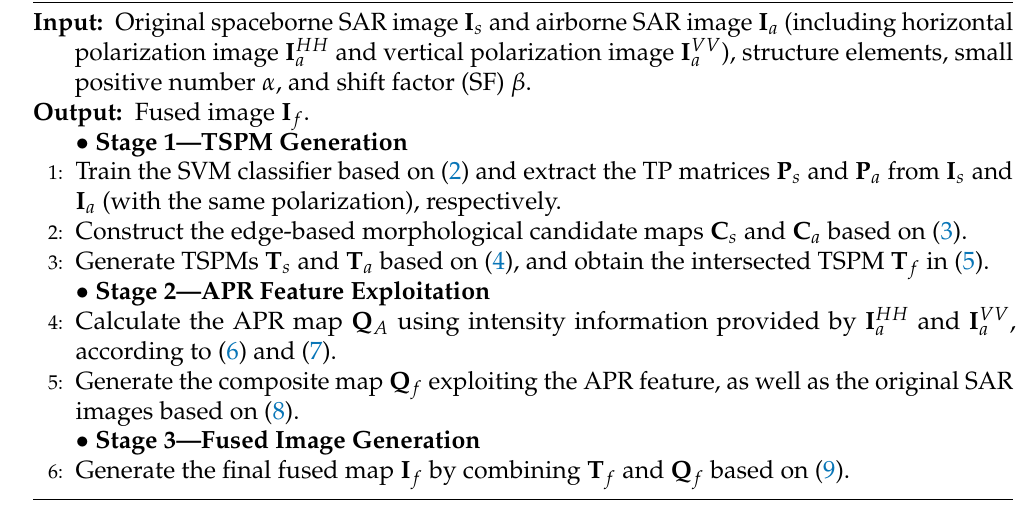
Algorithm 1 The proposed TPPIE